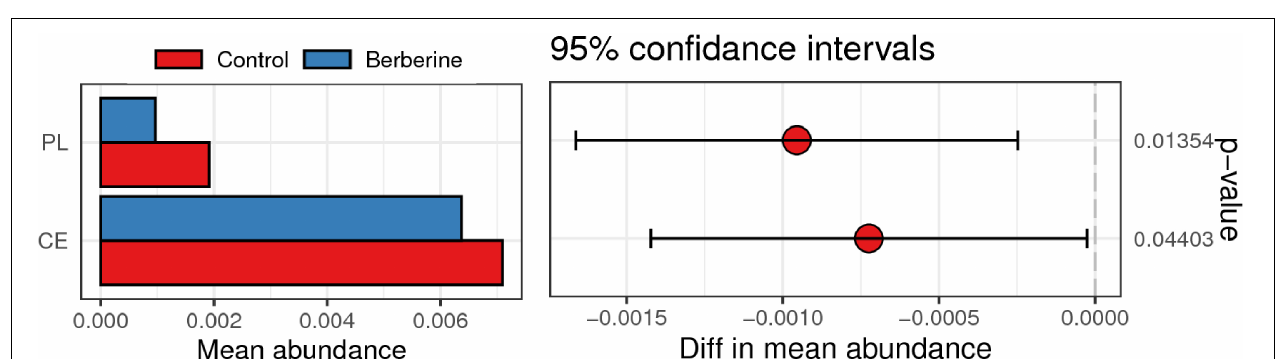
FIGURE 5 | ANOVA test of berberine on microbial species of pig gut microbiome.